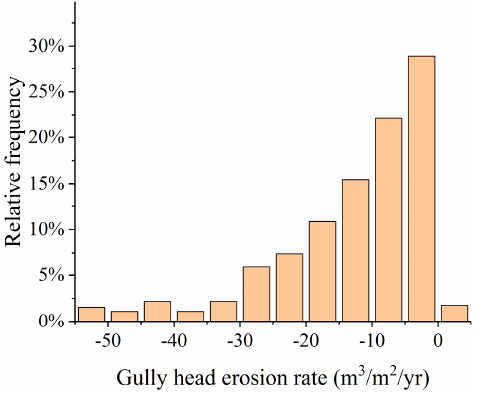
Figure 19. Distributions of the gully head erosion rates.